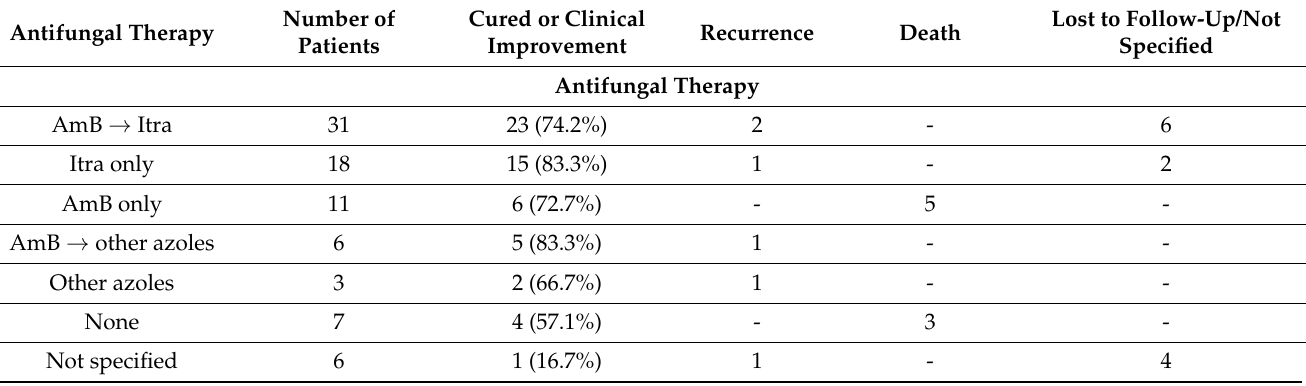
Table 5. Treatment and outcome of 83 children with histoplasmosis. Antifungal